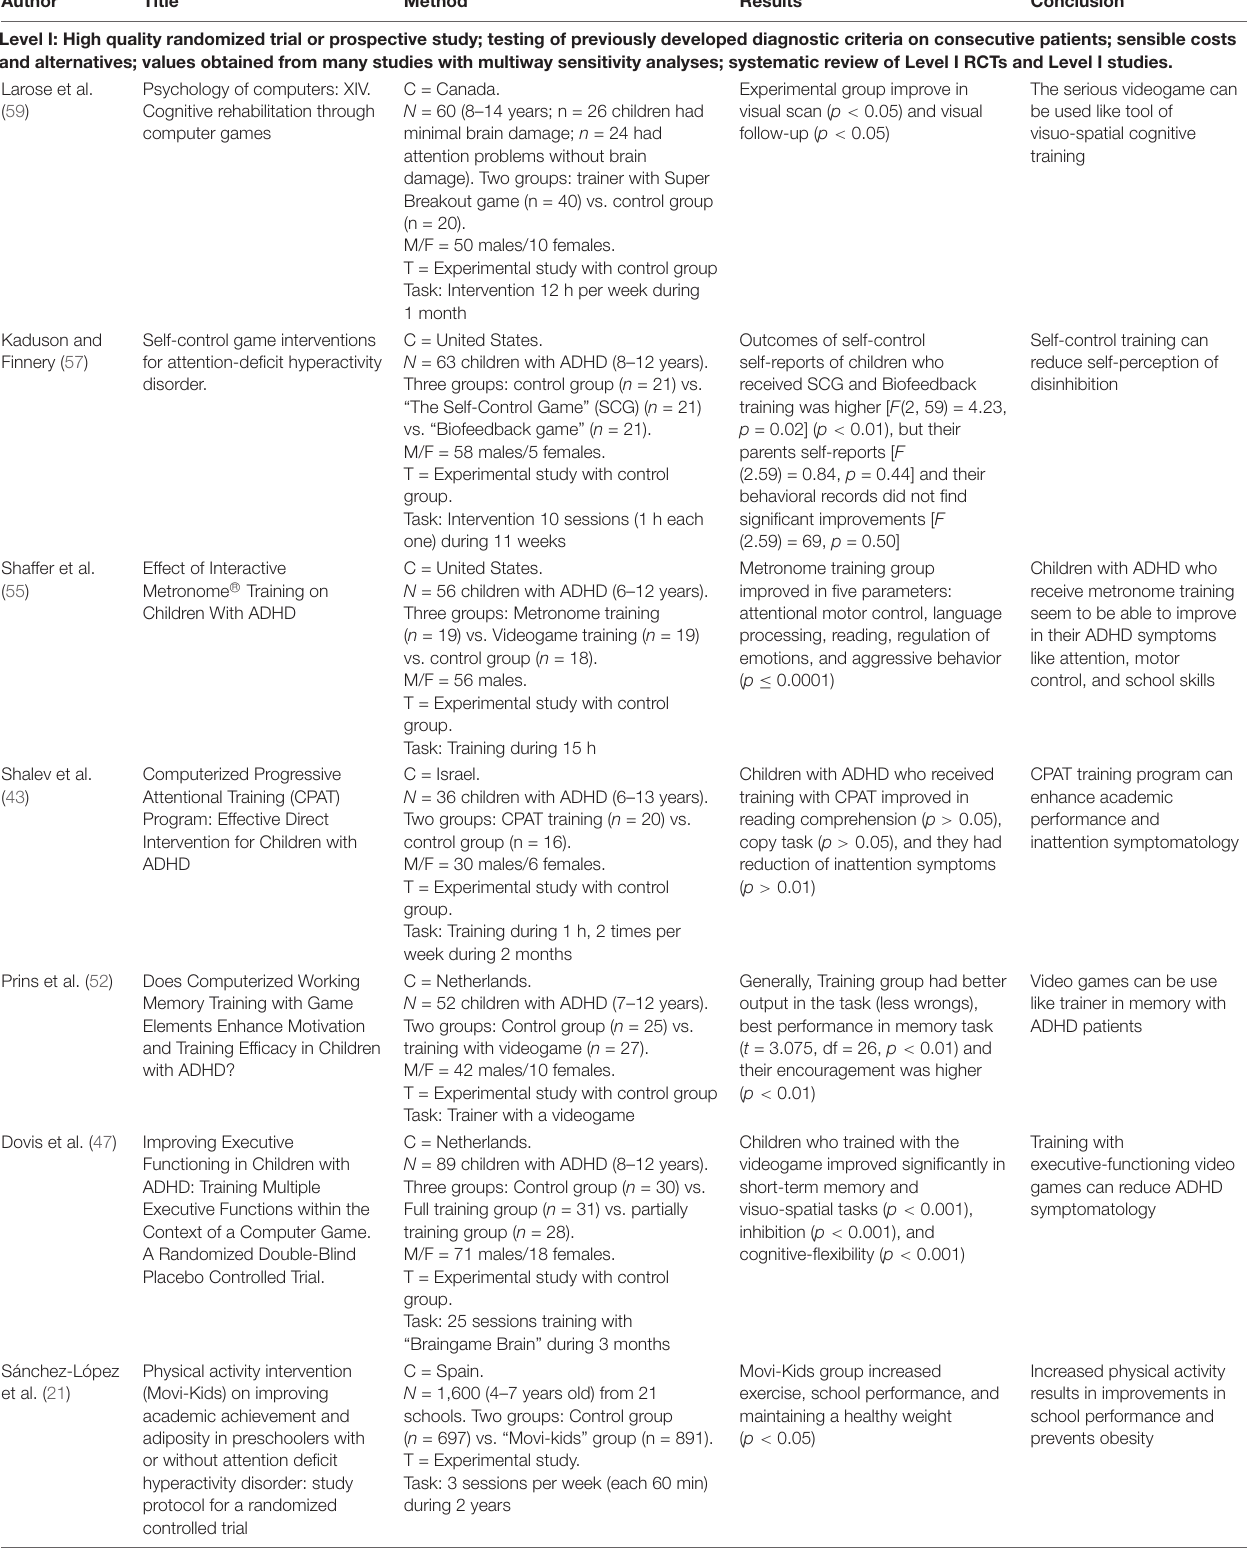
TABLE 1 | Serious video games for health as a therapeutic tool in ADHD